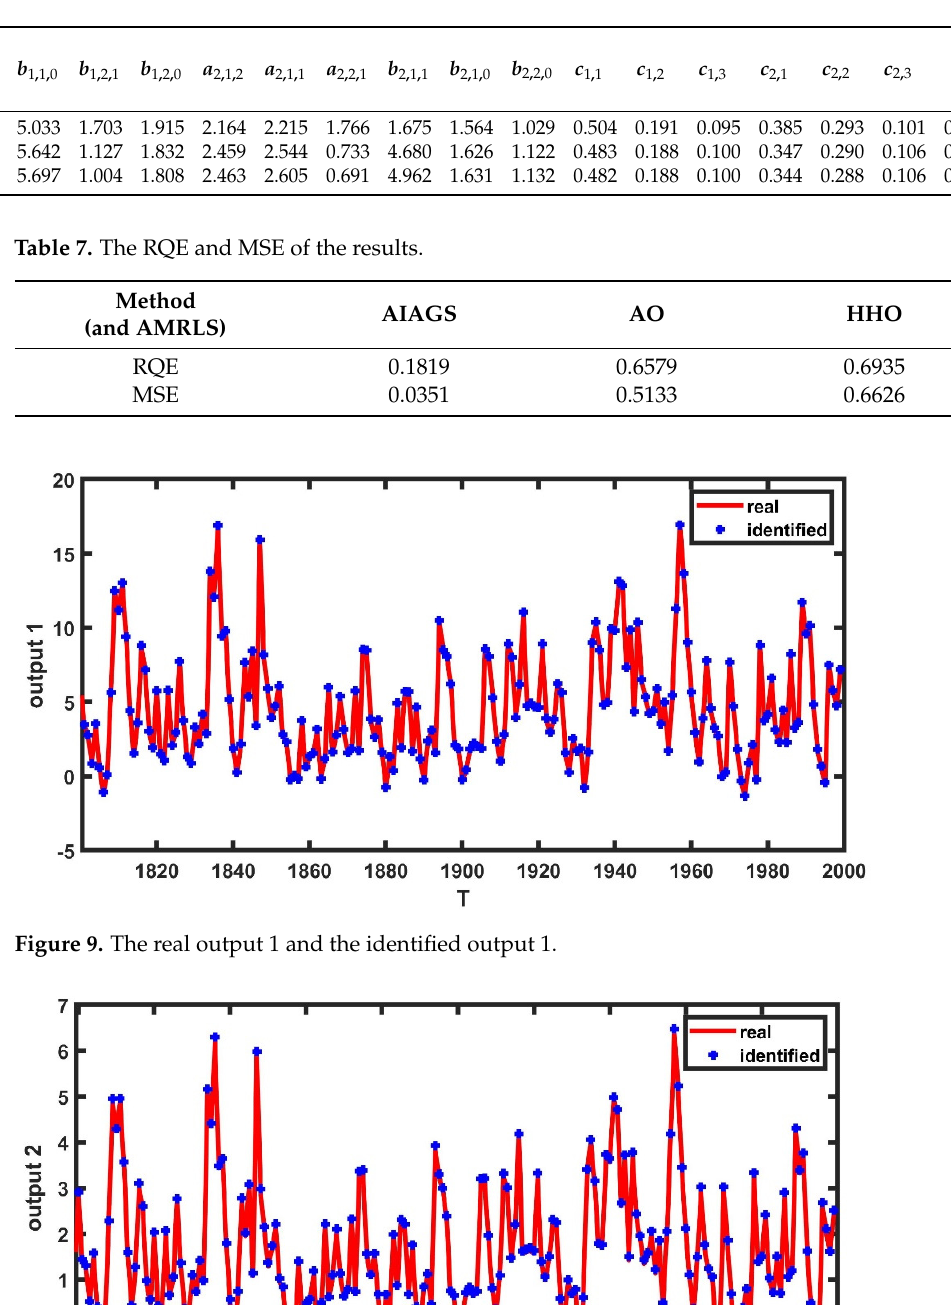
Table 6. The final identification results.